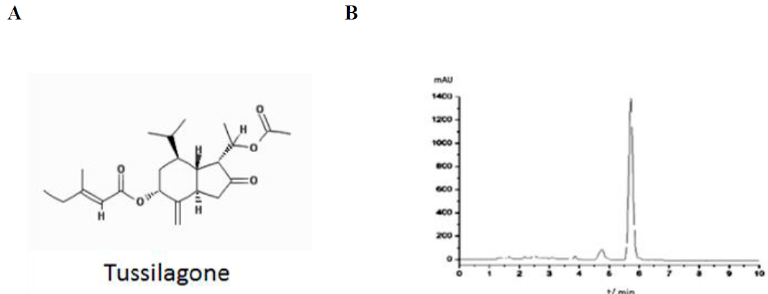
Figure 1. Structure of isolated Tussilagone (TS) and high-performance liquid chromatography (HPLC) chromatography ( A ) Structure of TS; ( B ) Analytical HPLC was performed over an SB-C 18 column (4.6 mm × 150 mm, 5 μ m) at 25 °C. Gradient elution was with methanol: water (85:15, v / v ) with a flow rate of 1.0 mL/min. Wavelength detection was at 220 nm.